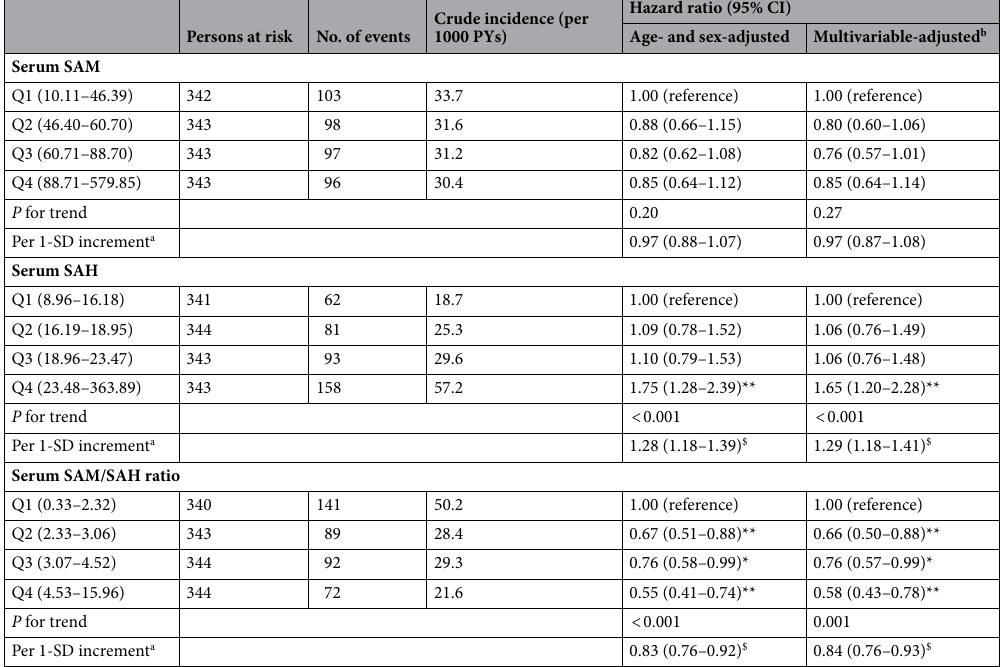
Table 4. The risk of all-cause death according to serum SAM, SAH and SAM/SAH ratio levels (2007–2017). CI confidence interval, PYs person-years, SAH s-adenosylhomocysteine, SAM s-adenosylmethionine, SD standard deviation. a 1-SDs of natural log-transformed values of serum SAM, serum SAH, and the serum SAM/ SAH ratio were 0.46, 0.32, and 0.54. b Adjusted for age, sex, education, hypertension, diabetes mellitus, serum total cholesterol, body mass index, history of stroke, current smoking, current drinking, regular exercise and use of vitamin B supplements. * P < 0.05, ** P < 0.01 versus Q1. $ P < 0.05 per 1-SD increment.